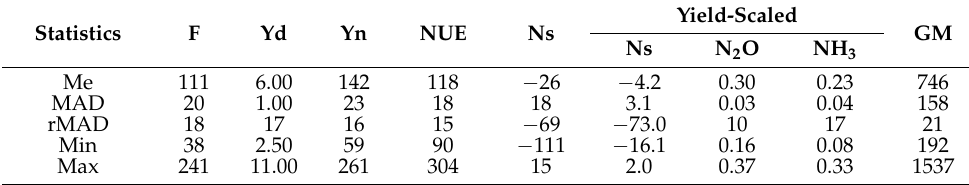
Table 3. Statistics for farm fields where NUE ≥ 90% (n = 1830); F, Yn, Ns (kg N · ha − 1 ); Yd (Mg · ha − 1 );